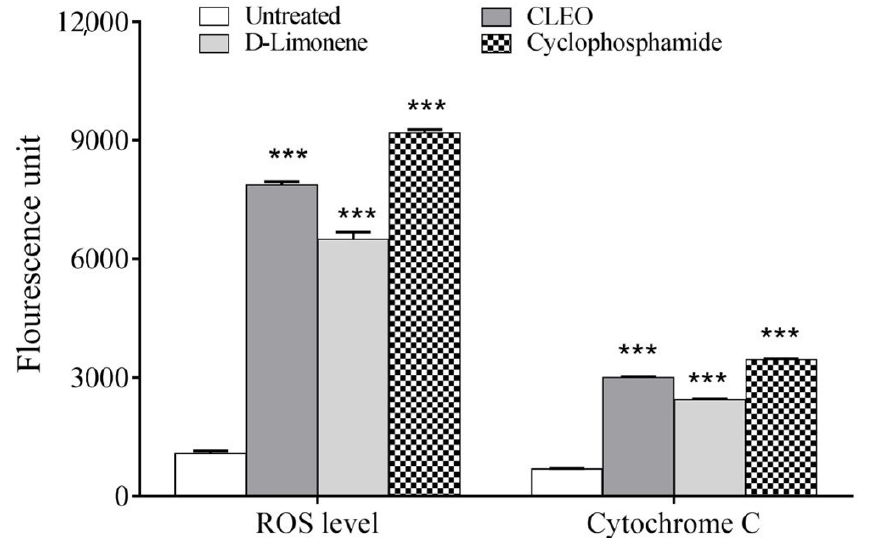
Figure 3. The mechanistic bases of action of the Citrus limetta peel essential oil along with the standard anticancer drug, cyclophosphamide, at their respective IC 50 values. (*** indicate p < 0.001).